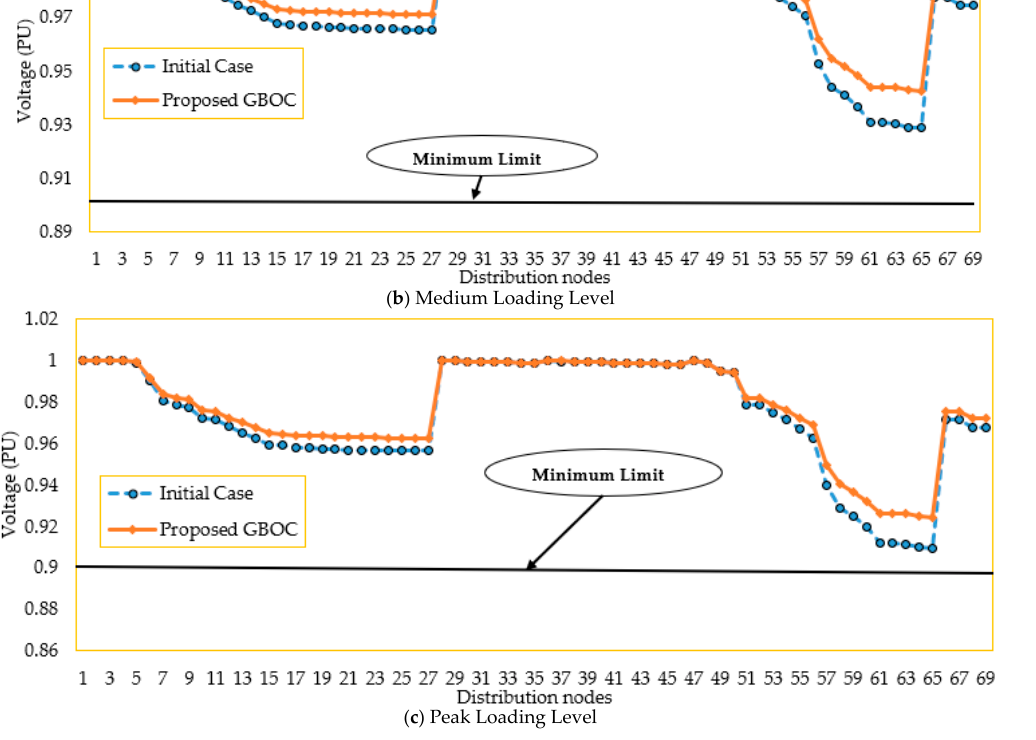
Figure 15. Voltage profile for the IEEE 69-distribution system based on the proposed GBOC versus initial case.